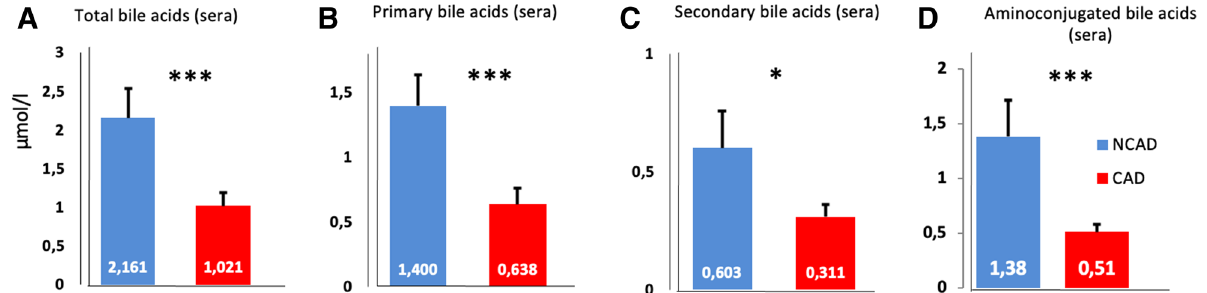
Figure 2. Comparison of bile acids concentrations in sera in non-coronary artery disease (blue bars) and coronary artery disease (red bars) patients. Concentrations (µmol/l) of total ( A ), primary ( B ), secondary ( C ) and amino-conjugated ( D ) bile acids in sera. Image credit: Graphpad 6.0, https:// www. graph pad. com/ scien tific- softw are/